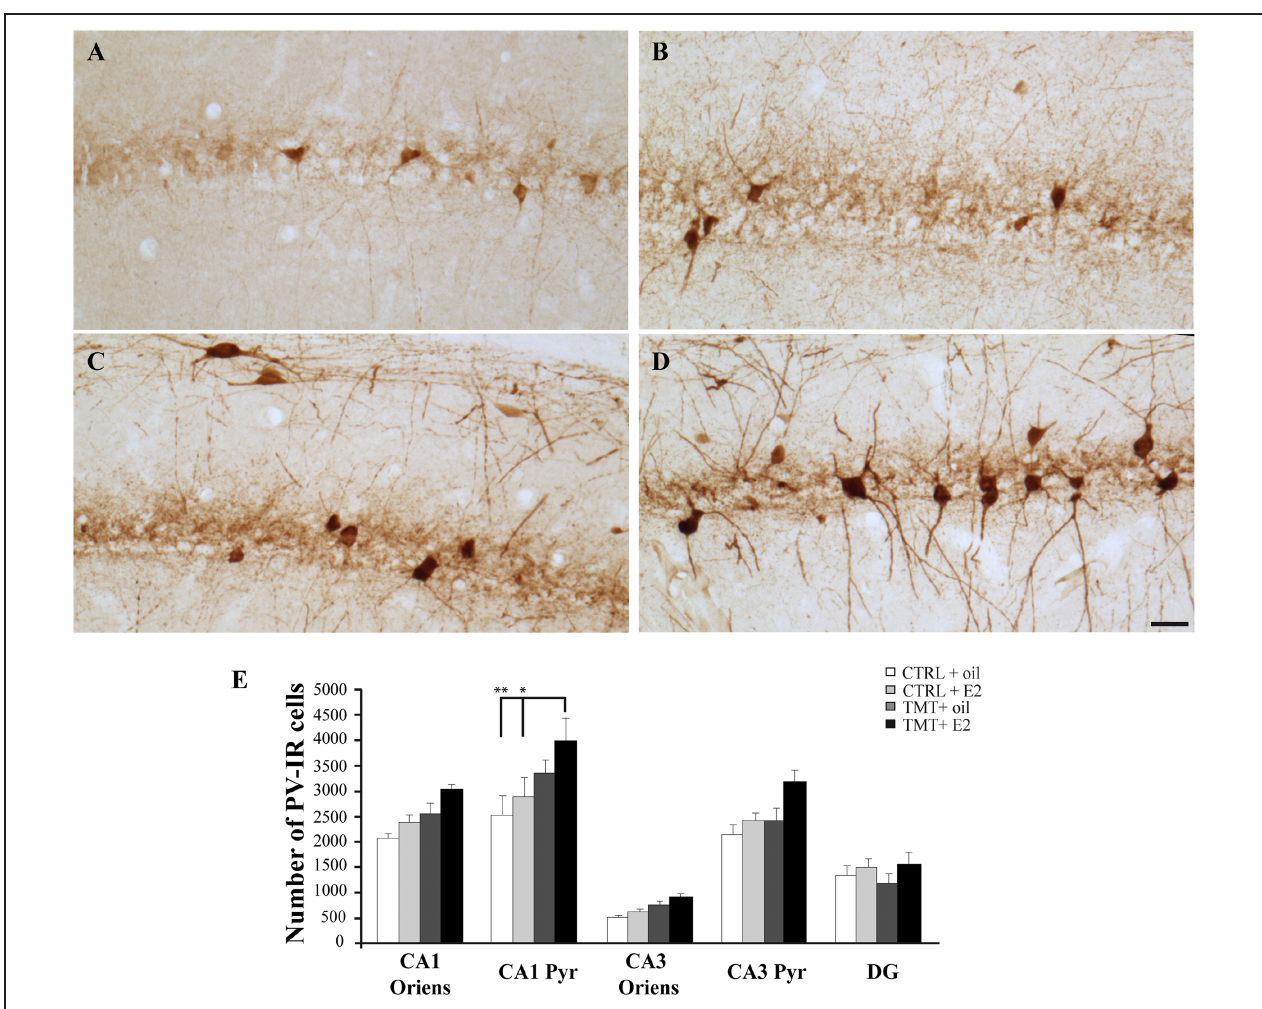
FIGURE 8 | Distribution and quantitative analysis of parvalbumin (PV)-immunoreactive (IR) neurons in the CA1 hippocampal region of the different experimental groups. (A–D) Representative micrographs of PV-stained hippocampal sagittal sections from CA1 region of CTRL + oil- (A) , CTRL + E2- (B) , TMT + oil- (C) , and TMT + E2- (D) treated rats. A higher number of PV-IR cells is detectable in the CA1 pyramidal layer of TMT + E2-treated rats compared with both control groups. Scale bar: 50 μ m. (E) Number of PV-IR neurons in different hippocampal subfields of the different experimental groups. A significantly higher number of PV-IR cells is evident in the CA1 pyramidal layer of TMT + E2-treated rats compared with both control groups. The values are given as means ± S.E. ( ∗ p < 0.05, ∗∗ p <